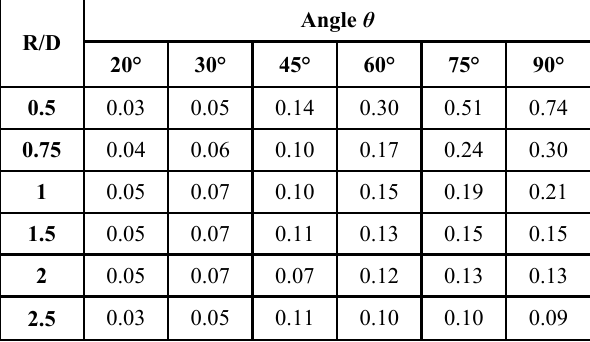
Table 3. Designated from the simulations minor loss coefficients ξ for elbow with circular cross section